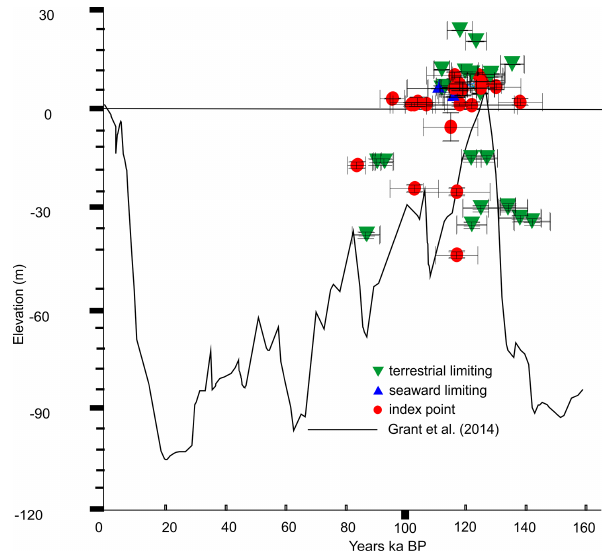
Figure 4. Sea-level index points, together with seaward and land- ward limiting points for all available data from the Angolan, Namib- ian and South African coasts. Plotted data span MIS 5a to e. To provide temporal context, the Red Sea sea-level curve of Grant et al. (2014) is